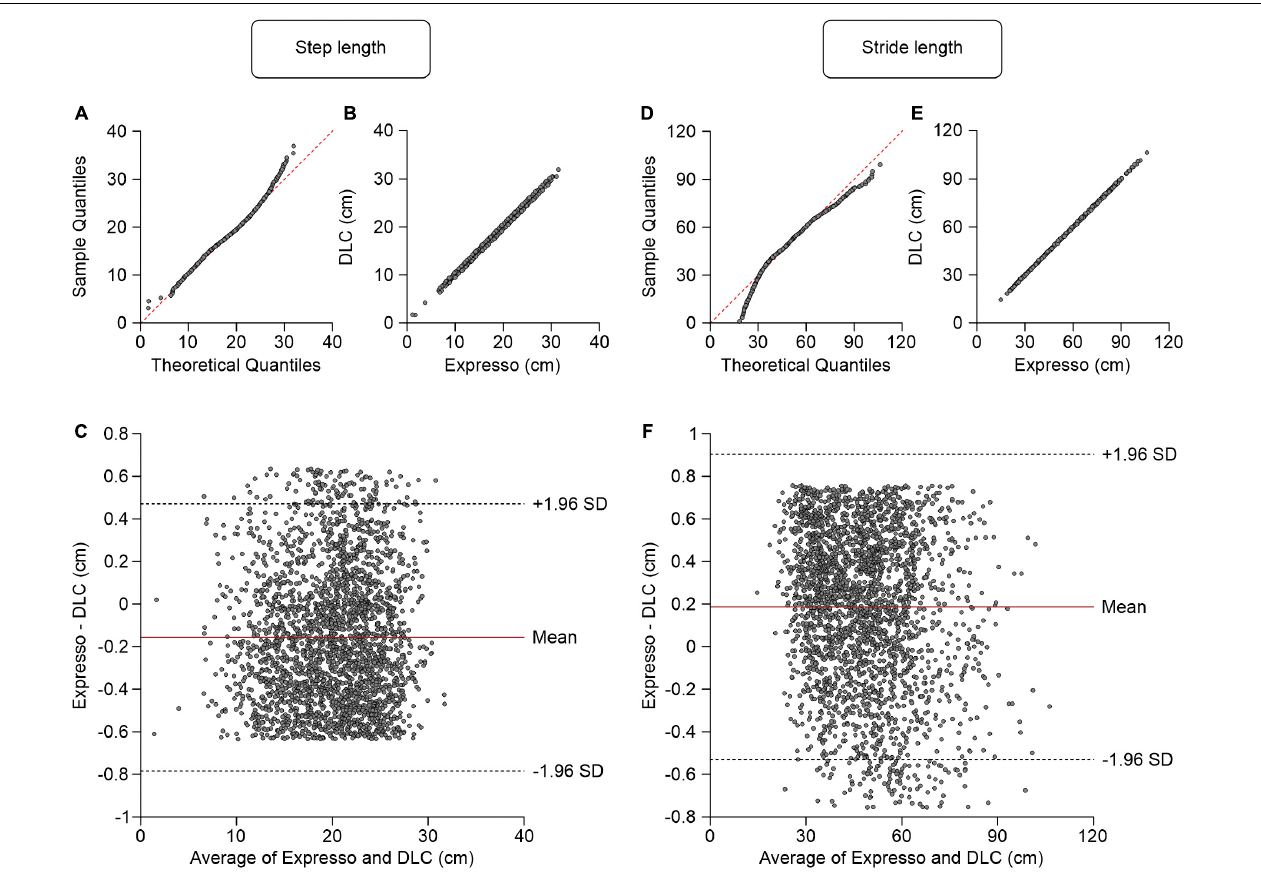
FIGURE 2 | Comparison of step and stride lengths measured with data from Expresso and DLC. (A) Step length QQ-plot where the red dashed line represents a perfect normal distribution. (B) Step length scatter plot of values obtained with Expresso and DLC. (C) Bland–Altman plot of step length measurements from Expresso and DLC. The solid red line is the mean difference between the two methods and black dashed lines show ± 1.96 standard deviations. (D) Stride length QQ-plot where the red dashed line represents a perfect normal distribution. (E) Stride length scatter plot of values obtained with Expresso and DLC. (F) Bland–Altman plot of stride length measurements from Expresso and DLC. The solid red line is the mean difference between two methods and black dashed lines show ± 1.96 standard deviations.